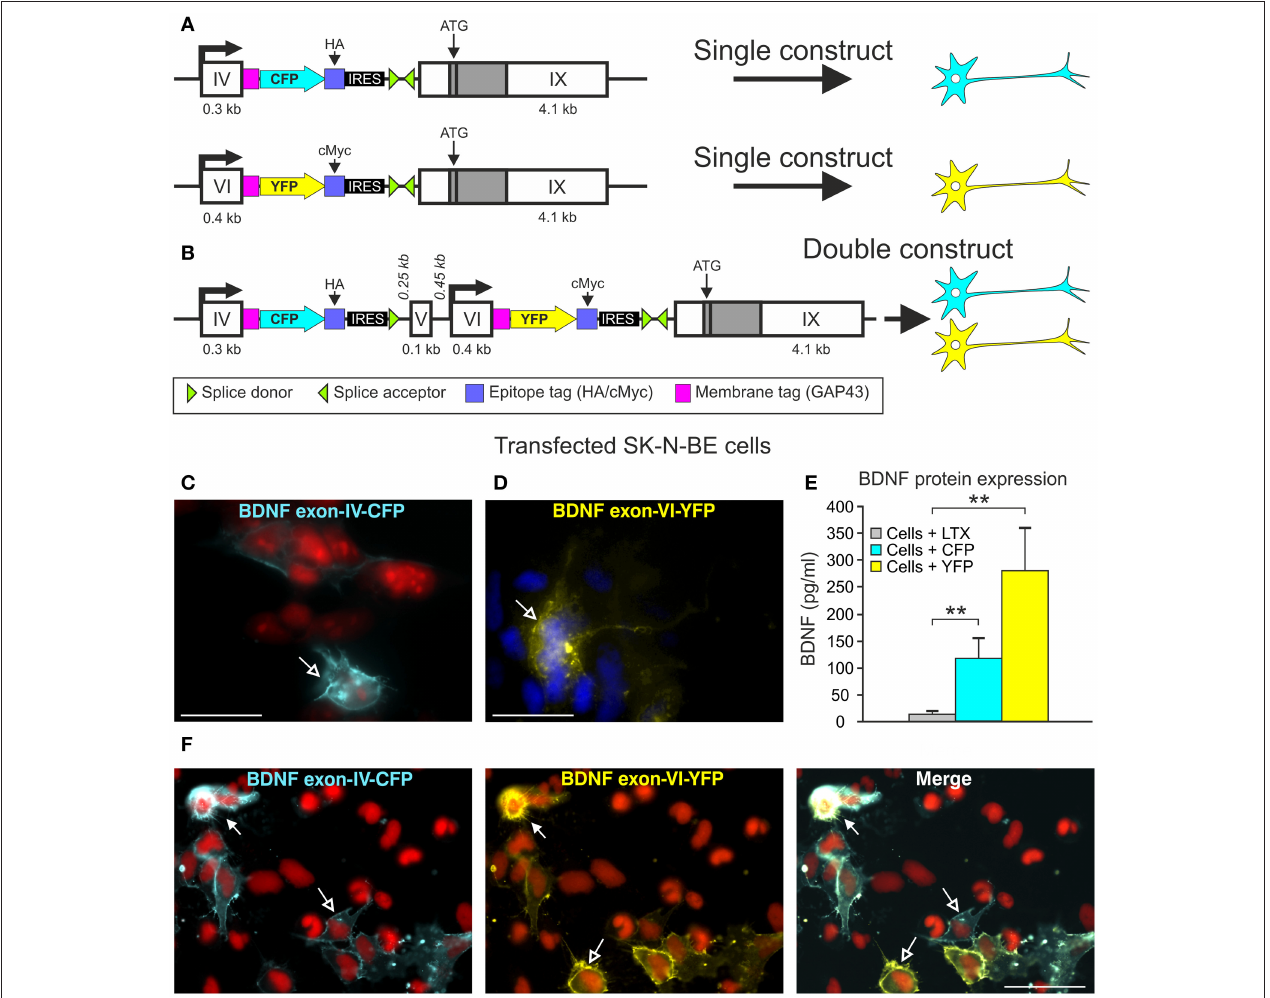
FIGURE 1 | BLEV construct and verification of the in vitro . (A) Schematic drawing of the Bdnf exon-IV-CFP and Bdnf exon-VI-YFP single constructs used in cell culture. (B) Schematic drawing of the Bdnf exon-IV-CFP and exon-VI-YFP double construct used in cell culture. (C,D) CFP expression of the Bdnf exon-IV-CFP single construct (blue, left panel, nuclear staining: propidium iodide, in red) and YFP expression of the Bdnf exon-VI-YFP single construct (yellow, right panel, nuclear staining: DAPI, in blue). (E) ELISA of BDNF protein in SK-N-BE cells transfected with either the Bdnf exon-IV-CFP single construct or the Bdnf exon-VI-YFP single construct. BDNF is not expressed in cells treated with Lipofectamine (LTX, gray bar) only. BDNF is expressed in SK-N-BE cells transfected with either of the two single constructs (blue bar: Bdnf exon-IV-CFP; yellow bar: Bdnf exon-VI-YFP). Data are shown as mean BDNF concentration (pg/ml) ± SEM [1-way ANOVA: F (3,36) = 8.35 p = 0.0002; post-test 2-sided Student’s t -test: CFP p = 0.008; YFP p = 0.003; done in duplicate for 4 independent experiments]. (F) SK-N-BE cells transfected with the Bdnf exon-IV-CFP exon-VI-YFP double construct. The left panel shows the CFP expression (blue), the middle panel shows the YFP expression (yellow), and the right panel shows a merged image of Bdnf exon-IV-CFP and Bdnf exon-VI-YFP expression. Open arrows show cells expressing either CFP or YFP, filled arrows show cells expressing CFP and YFP. Nuclear staining in red (propidium iodide). (C,D) scale bars = 20 µ m; (F) scale bar = 50 µ